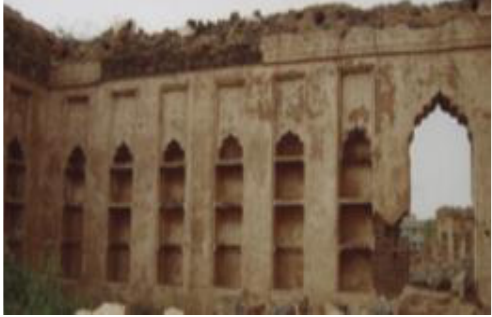
(Figure. 17) Inner wall closets with broken arches, an Idrisid Palace 14 th AH/20 th